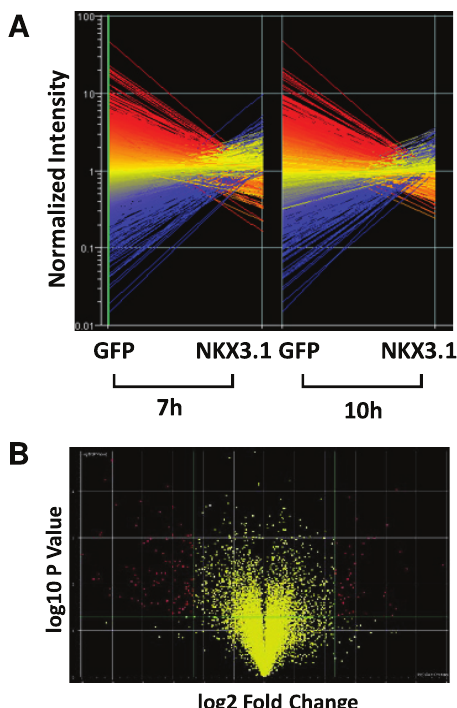
Figure S2. Global gene expression signature of NKX3.1 expression in LH cells. ( A ) Differential gene expression 7 and 10 h after NKX3.1 expression in LH cells. Note the overall similarity of gene expression differences between GFP and NKX3.1 expressing LH cells at both time points (7 h and 10 h). ( B ) “Volcano Plot” of differentially expressed genes at the 7 h time point. Features marked in red differed significantly 5-fold between GFP and NKX3.1 expressing samples.